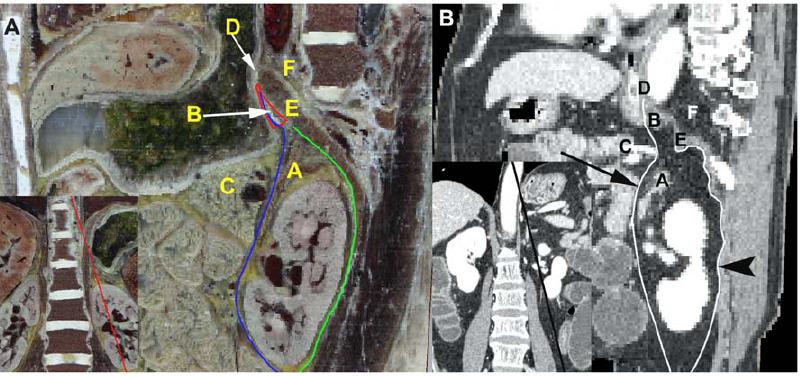
Figure 4. Manifestation of the spatial relationship between the LES and left retroperitoneal space on oblique sagittal planes. (A, B) Visualization of the communication relationship between the left retroperitoneal space and the LES from the lateral superior view on CVH2 and CT images, respectively. The anterior renal fascia is represented as a blue line and labeled by a black arrow on CVH2 and CT images, respectively. The posterior renal fascia is represented as a green line and labeled by an arrowhead on CVH2 and CT images, respectively. A: left adrenal gland; B: LES; C: pancreas; D: esophageal hiatus; E: left diaphragm; F: retrocrural space.